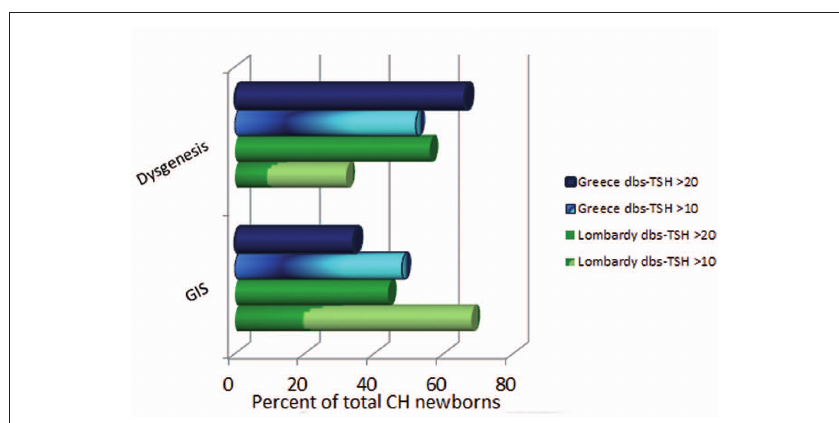
Figure 1 | Congenital hypothyroidism (CH) classification according to different dbs–TSH cutoff values in greece and Lombardy. Observe the prevalence of dysgenetic CH using a dbs–TSH cutoff of 20 mU/L and the shift toward a higher prevalence of GIS defects in the same newborn population by lowering the dbs–TSH cutoff at 10 mU/L.